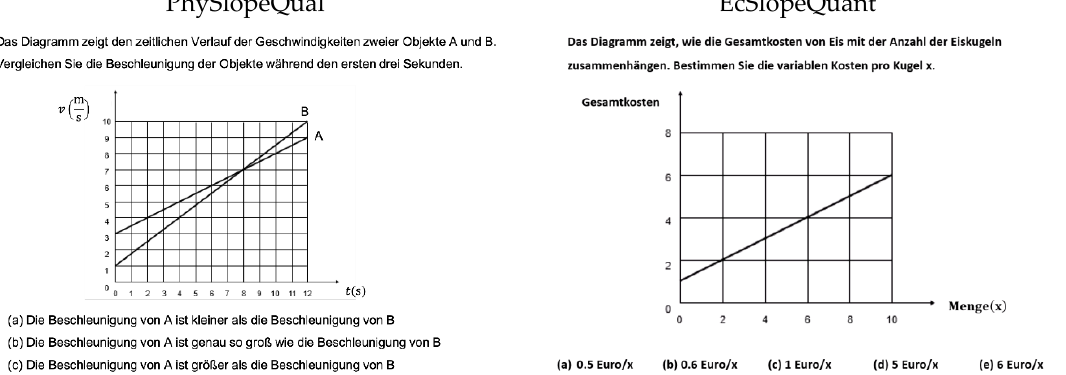
Figure 1. Original tasks PhySlopeQual and EcSlopeQuant solved by the participants.